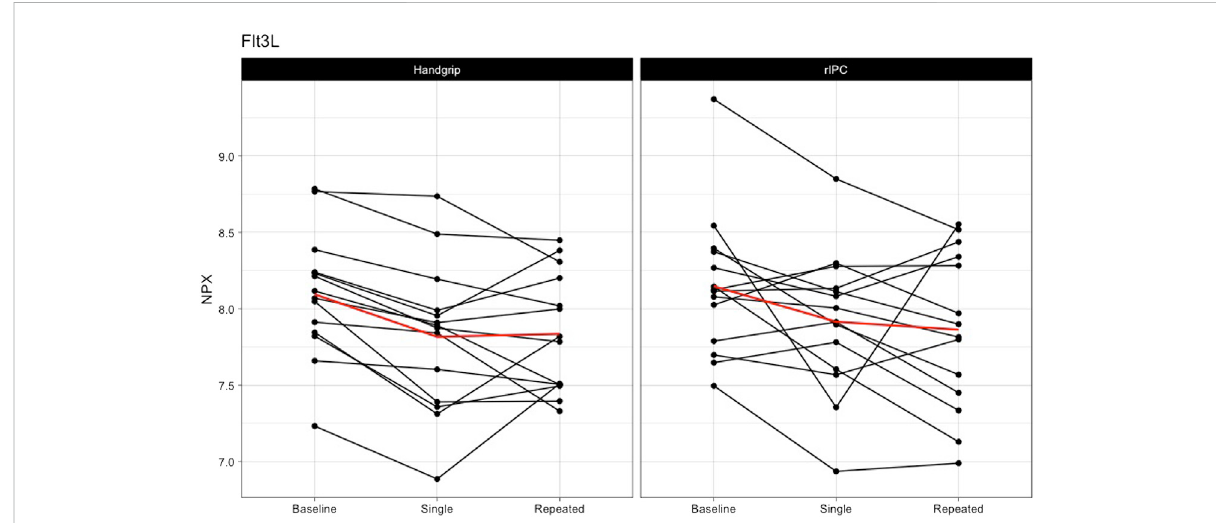
FIGURE 3 ChangesinFlt3Laftersingleandrepeatedpreconditioning.ThechangesintheNPXofFlt3L(onthey-axis)betweenbaselineandaftersingleand repeated intervention (on the x-axis) for both the handgrip intervention (on the left) and the remote ischemic preconditioning (on the right). Each black line represents one participant and the red line is the mean for all the participants together. rIPC = Remote ischemic preconditioning. NPX = Normalised protein expression; Flt3L = FMS-related tyrosine kinase 3 ligand.